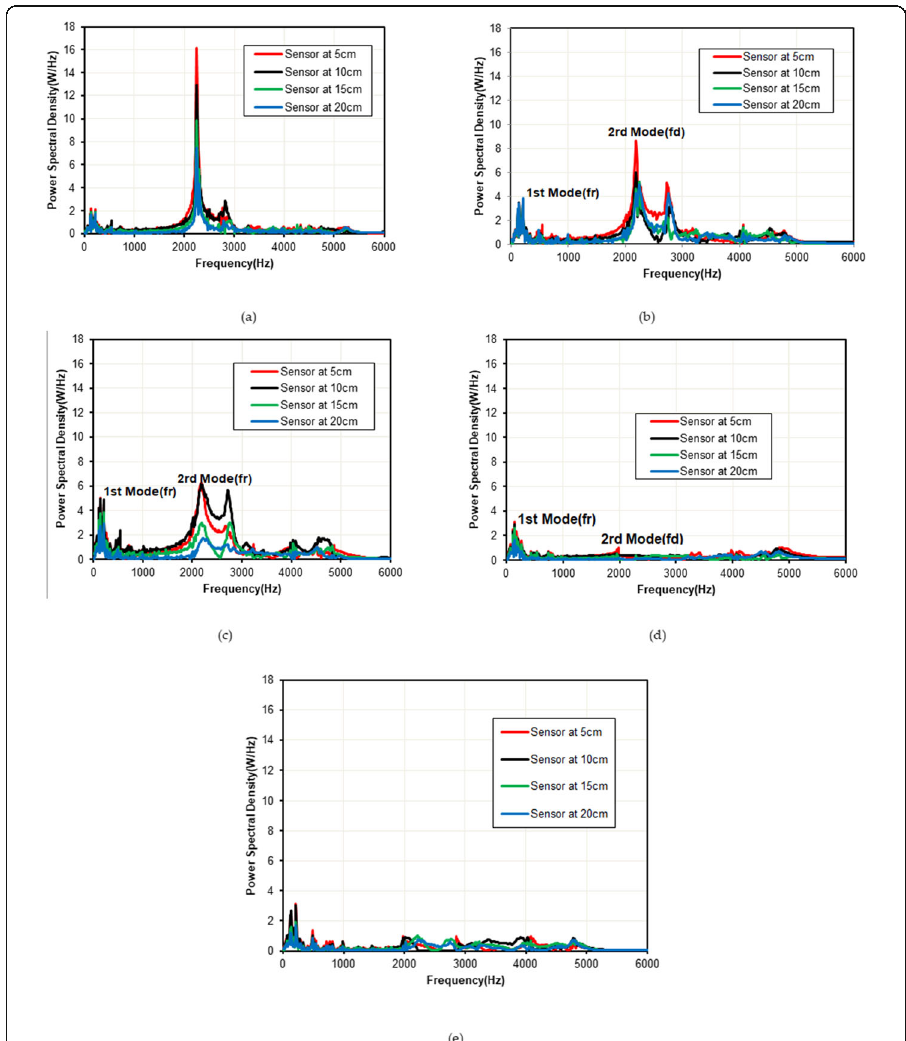
Fig. 15 Concrete slab track with cavity: a Cavity size 5 cm × 5 cm × 5 cm. b Cavity size 5 cm × 5 cm